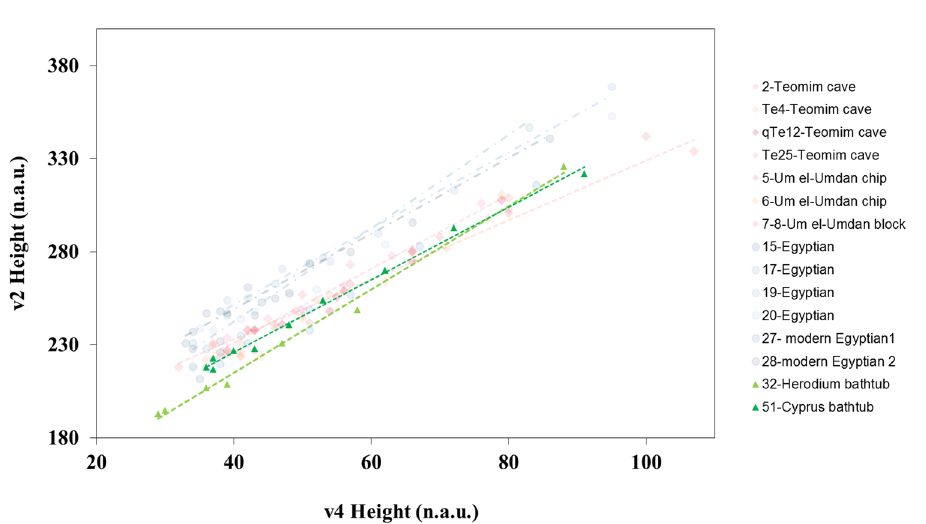
Figure 3. Routine FT-IR grinding curve results of the two bathtubs (triangles) over the background of the Israeli (diamond) and Egyptian (circle)